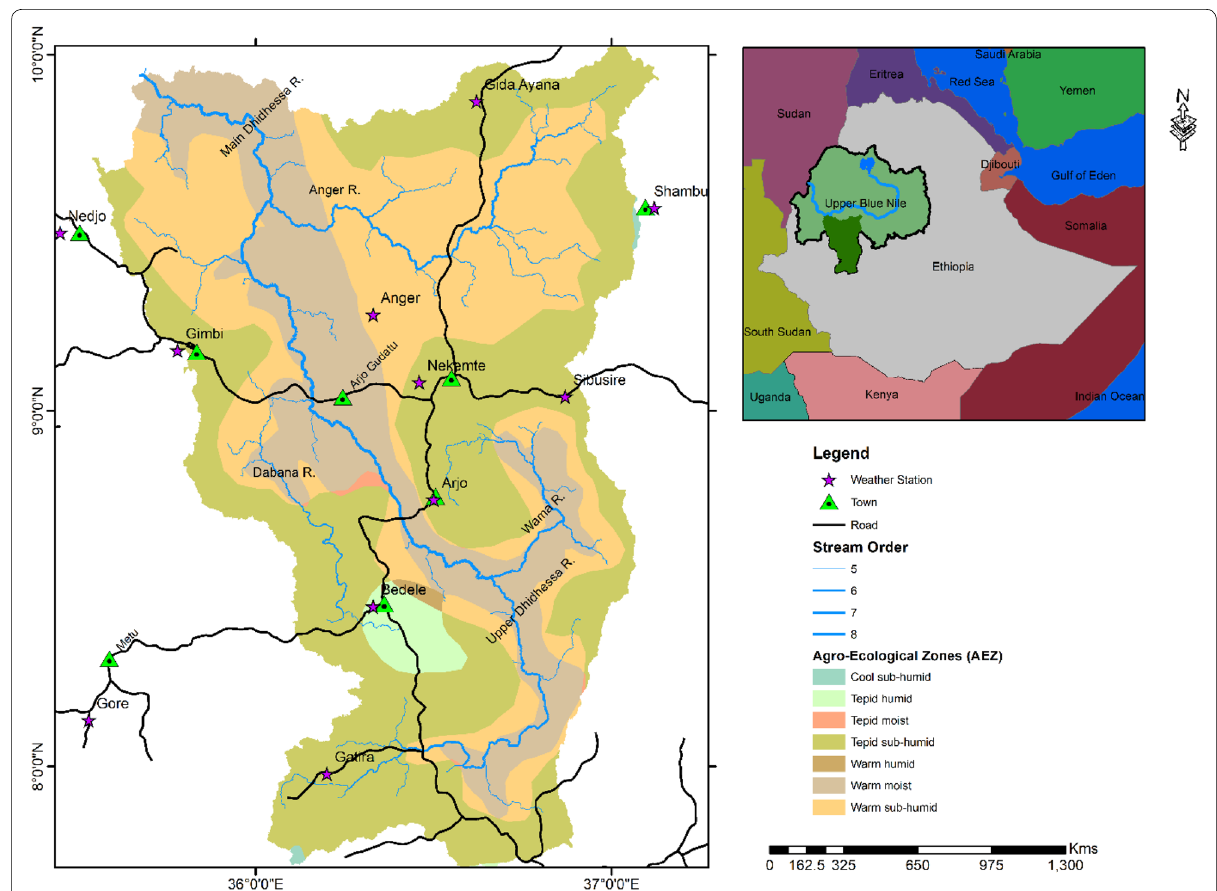
Fig. 1 Location map of the Dhidhessa River basin with ground